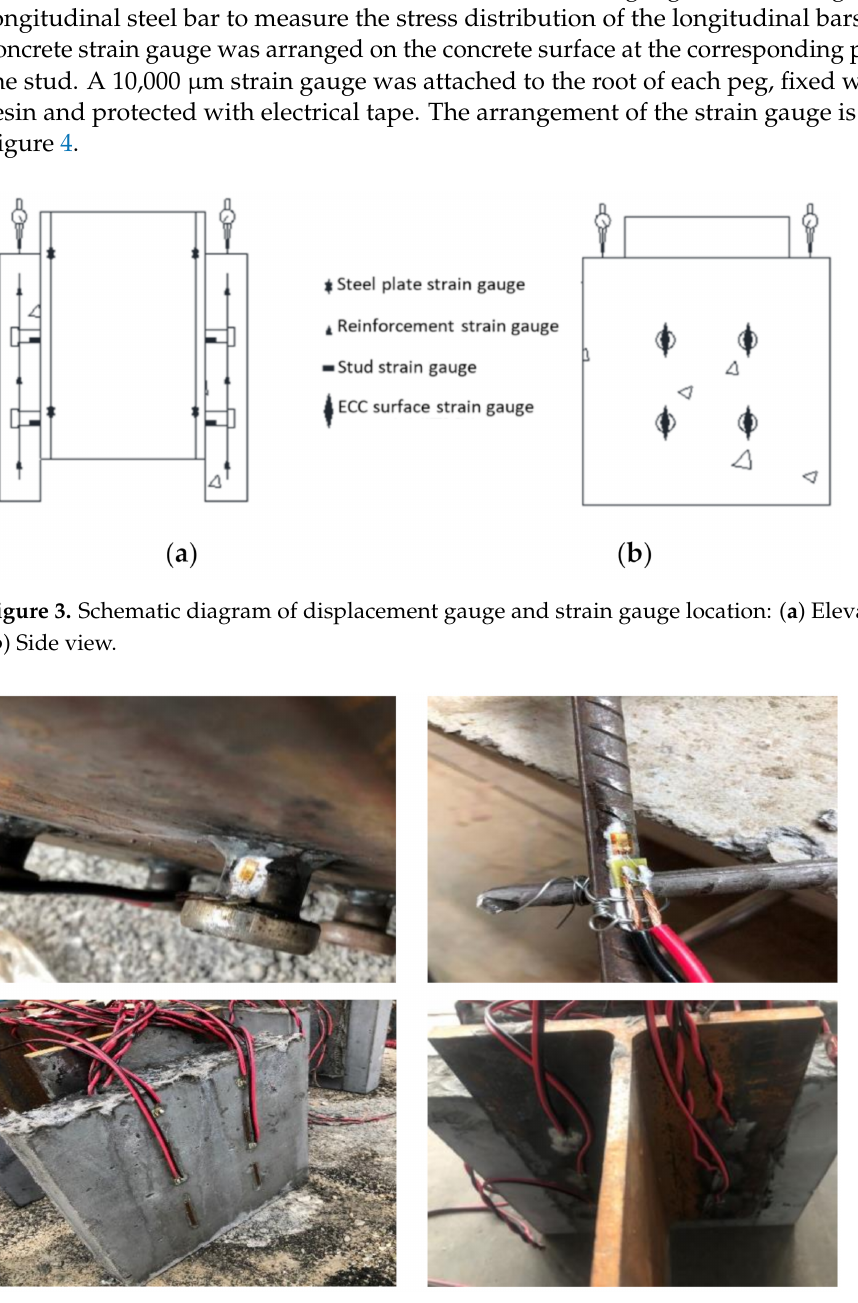
Figure 4. Physical map of the position of the strain